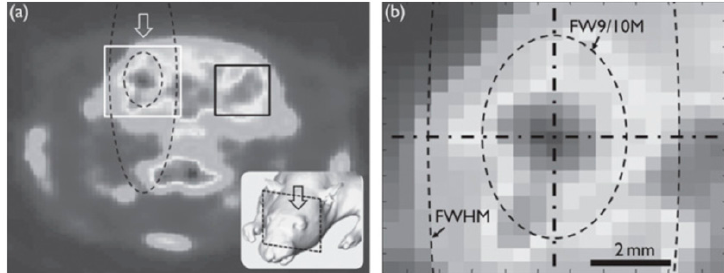
Figure 6. ( a ) Sonication effect illustrated by a PET image. The arrow indicates the sonication path and the black rectangle marks an unsonicated region. ( b ) A close-up view of the acoustic focus outlined by the white square in ( a ). The dashed lines encircle the full width at 90% maximum (FW9/10M) area (inner) and the full width at half maximum (FWHM) area (outer), respectively. (Image from Kim et al., 2014 [104]).